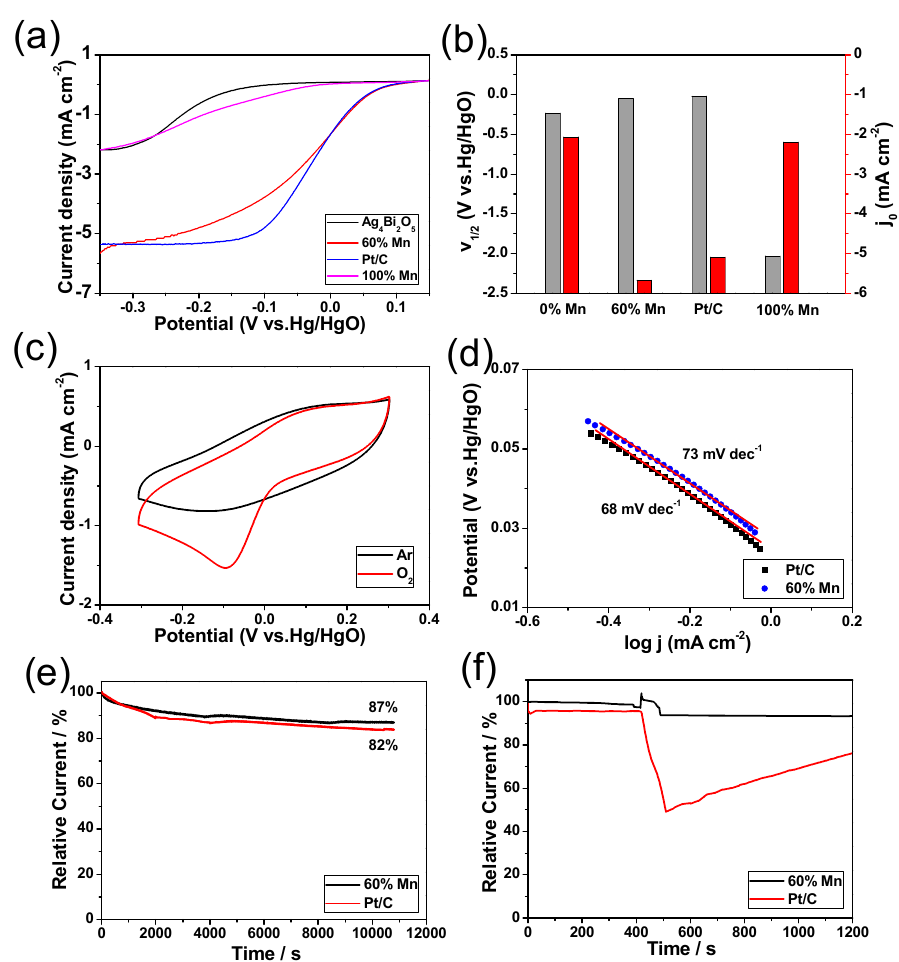
Figure 9. ( a ) LSV curves of Ag 4 Bi 2 O 5 with 60% Mn, Pt/C and MnO 2 by rotating disk electrode (RDE) in KOH solution with O 2 saturation at a speed of 5 mV s − 1 and a rotation speed of 1600 rpm, ( b ) comparison between commercial Pt/C and Ag 4 Bi 2 O 5 with 0% Mn, 60% Mn, 100% Mn, at half-wave potential (v 1/2 ) and current density (j), ( c ) cyclic voltammetry (CV) curves of Ag 4 Bi 2 O 5 with 60% Mn at a scan rate of 50 mV s − 1 with Ar and O 2 saturation, respectively, ( d ) Tafel curves of Ag 4 Bi 2 O 5 with 60% Mn and commercial Pt/C, ( e ) i-t chrono-amperometric curves of Ag 4 Bi 2 O 5 with 60% Mn and Pt/C at − 0.26 V with O 2 saturation at a rotation speed of 1600 rpm, ( f ) methanol tolerance of Ag 4 Bi 2 O 5 with 60% Mn and commercial Pt/C by chronoamperometric response with O 2 saturation for 1200 s and adding 3.0 mol L − 1 CH 3 OH at about the 420th second. Table 2. Comparison of oxygen reduction reaction (ORR) catalytic activities between Ag 4 Bi 2 O 5 with 60% Mn and the other relevant catalysts.